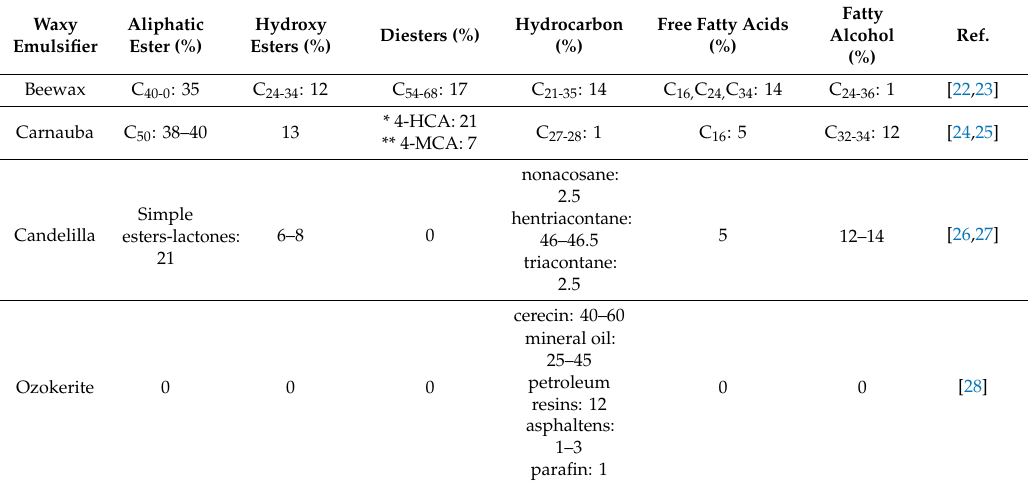
Table 1. Chemical composition of waxy